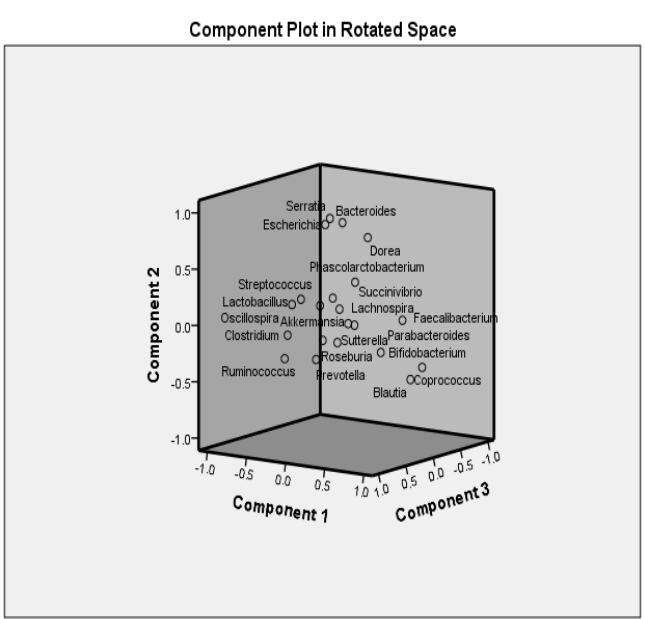
Fig. 2b. Spatial view of the relationship between the extracted factors and bacteria genus-groups among control.